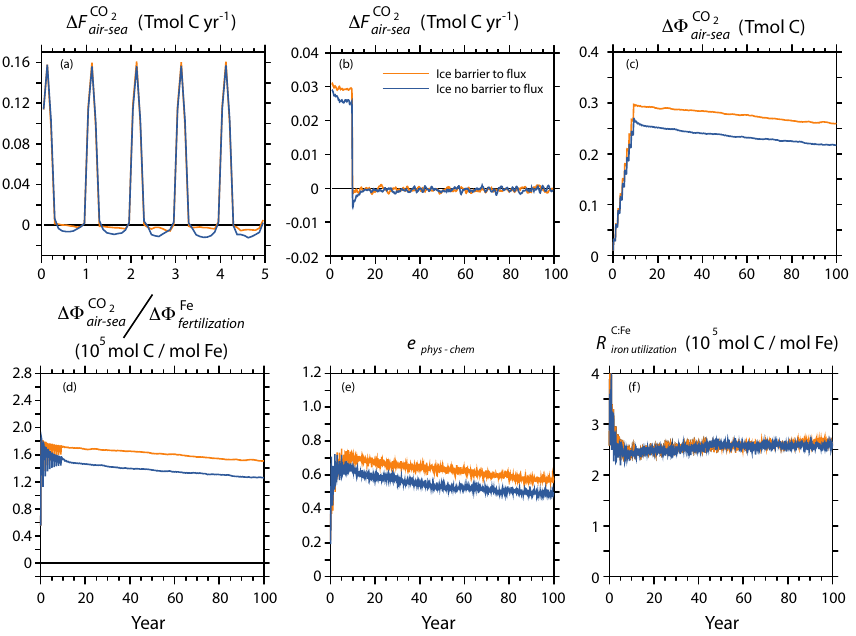
Fig. 10. Results from the 10x iron fertilization scenario at the Ross Sea site calculated the standard way with an ice barrier to CO 2 flux, and also with gas exchange allowed across the ice barrier. The figure shows: (a) the annual uptake of CO 2 plotted month by month for the first 5 years, 1F CO 2 ; (b) the annual uptake of CO 2 from the atmosphere for 100 years, 1F CO 2 air − sea the atmosphere, 18 CO 2 ; (d) the efficiency of CO 2 uptake with respect to iron addition, R C : Fe air − sea uptake efficiency e phys − chem ; and, (f) the biogeochemical response function, R C : Fe